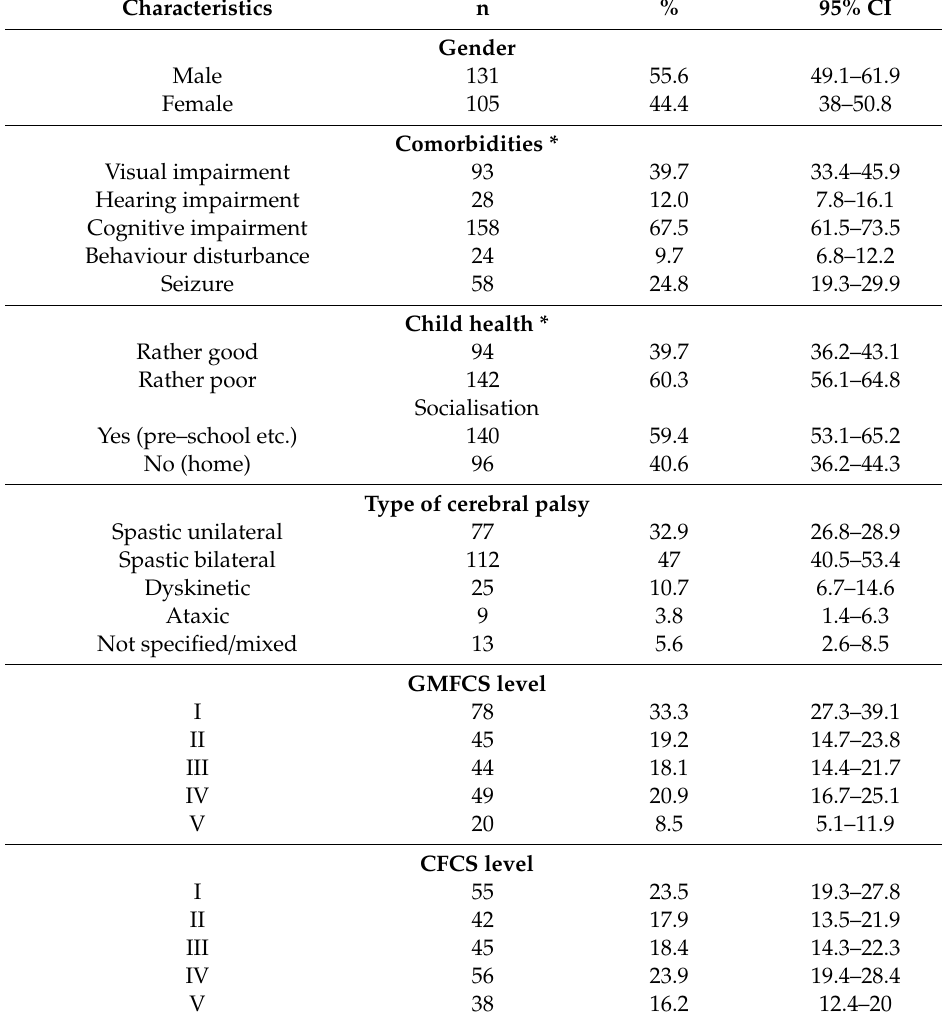
Table 5. Characteristics of the children with cerebral